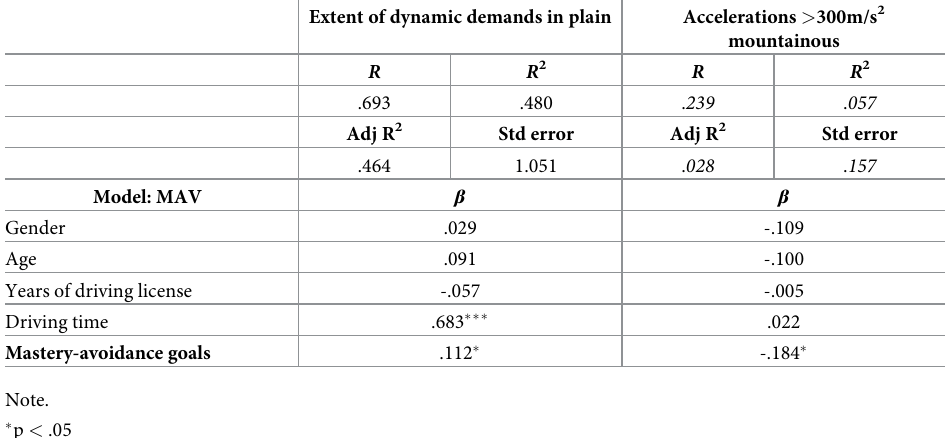
Table 5. Results of the regression analysis for mastery-avoidance goals with the road context.